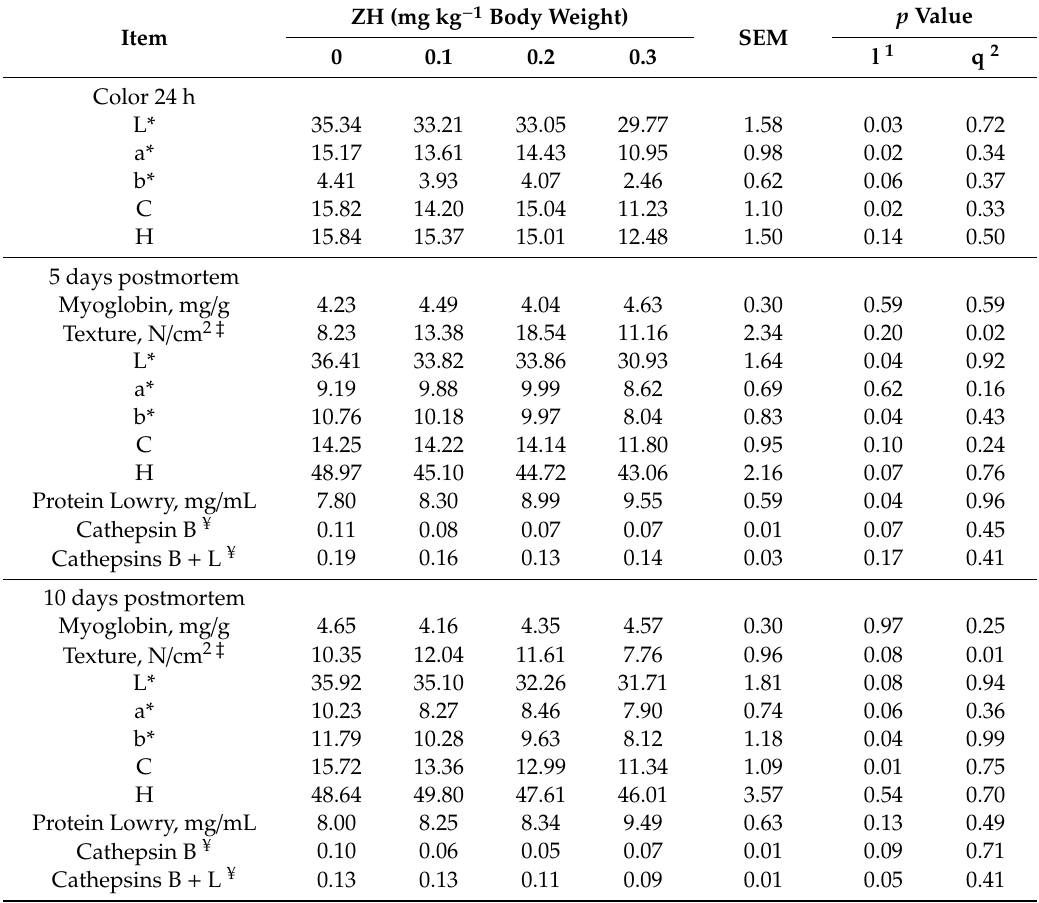
Table 6. Meat physicochemical characteristics of hair-breed lambs supplemented with ZH for 30 days.